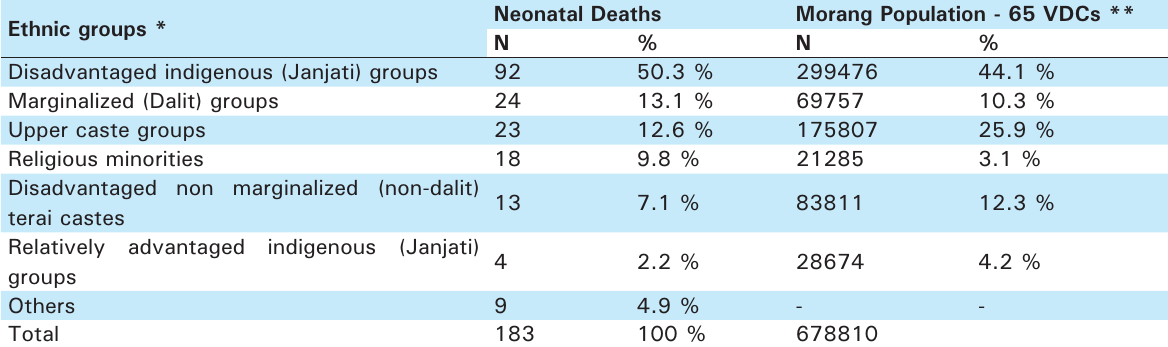
Table 4: Neonatal deaths as ascertained in various ethnic groups in the verbal autopsy Neonatal Deaths Morang Population - 65 VDCs ** Ethnic groups * N % N % Disadvantaged indigenous (Janjati) groups 92 50.3